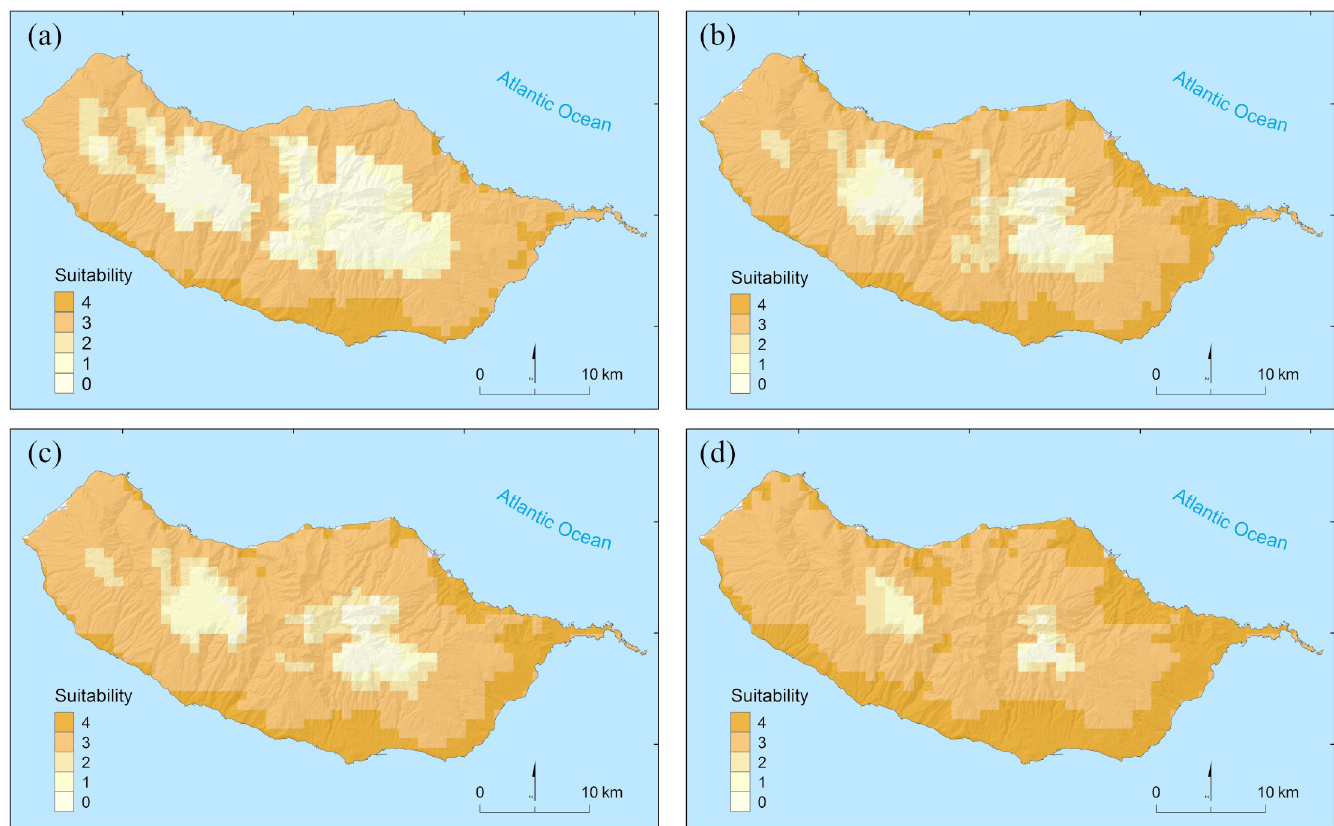
Fig 5. Inter-model consensus on climatic suitability for Aedes aegypti on Madeira Island. The highest (lowest) value indicates areas predicted as suitable (unsuitable) by all four algorithms (boosted regression trees, generalized linear models, generalized additive models and random forests) Intermediate values reflect disagreement between models and correspond to areas of higher uncertainty. Predictions are provided for current climatic conditions (a) and for climatic conditions projected for the mid of the 21 st century (2041–2060) under RCP2.6 (b), RCP4.5 (c) and RCP8.5 (d) (source of shapefile: https://www.dgterritorio.gov.pt/cartografia/